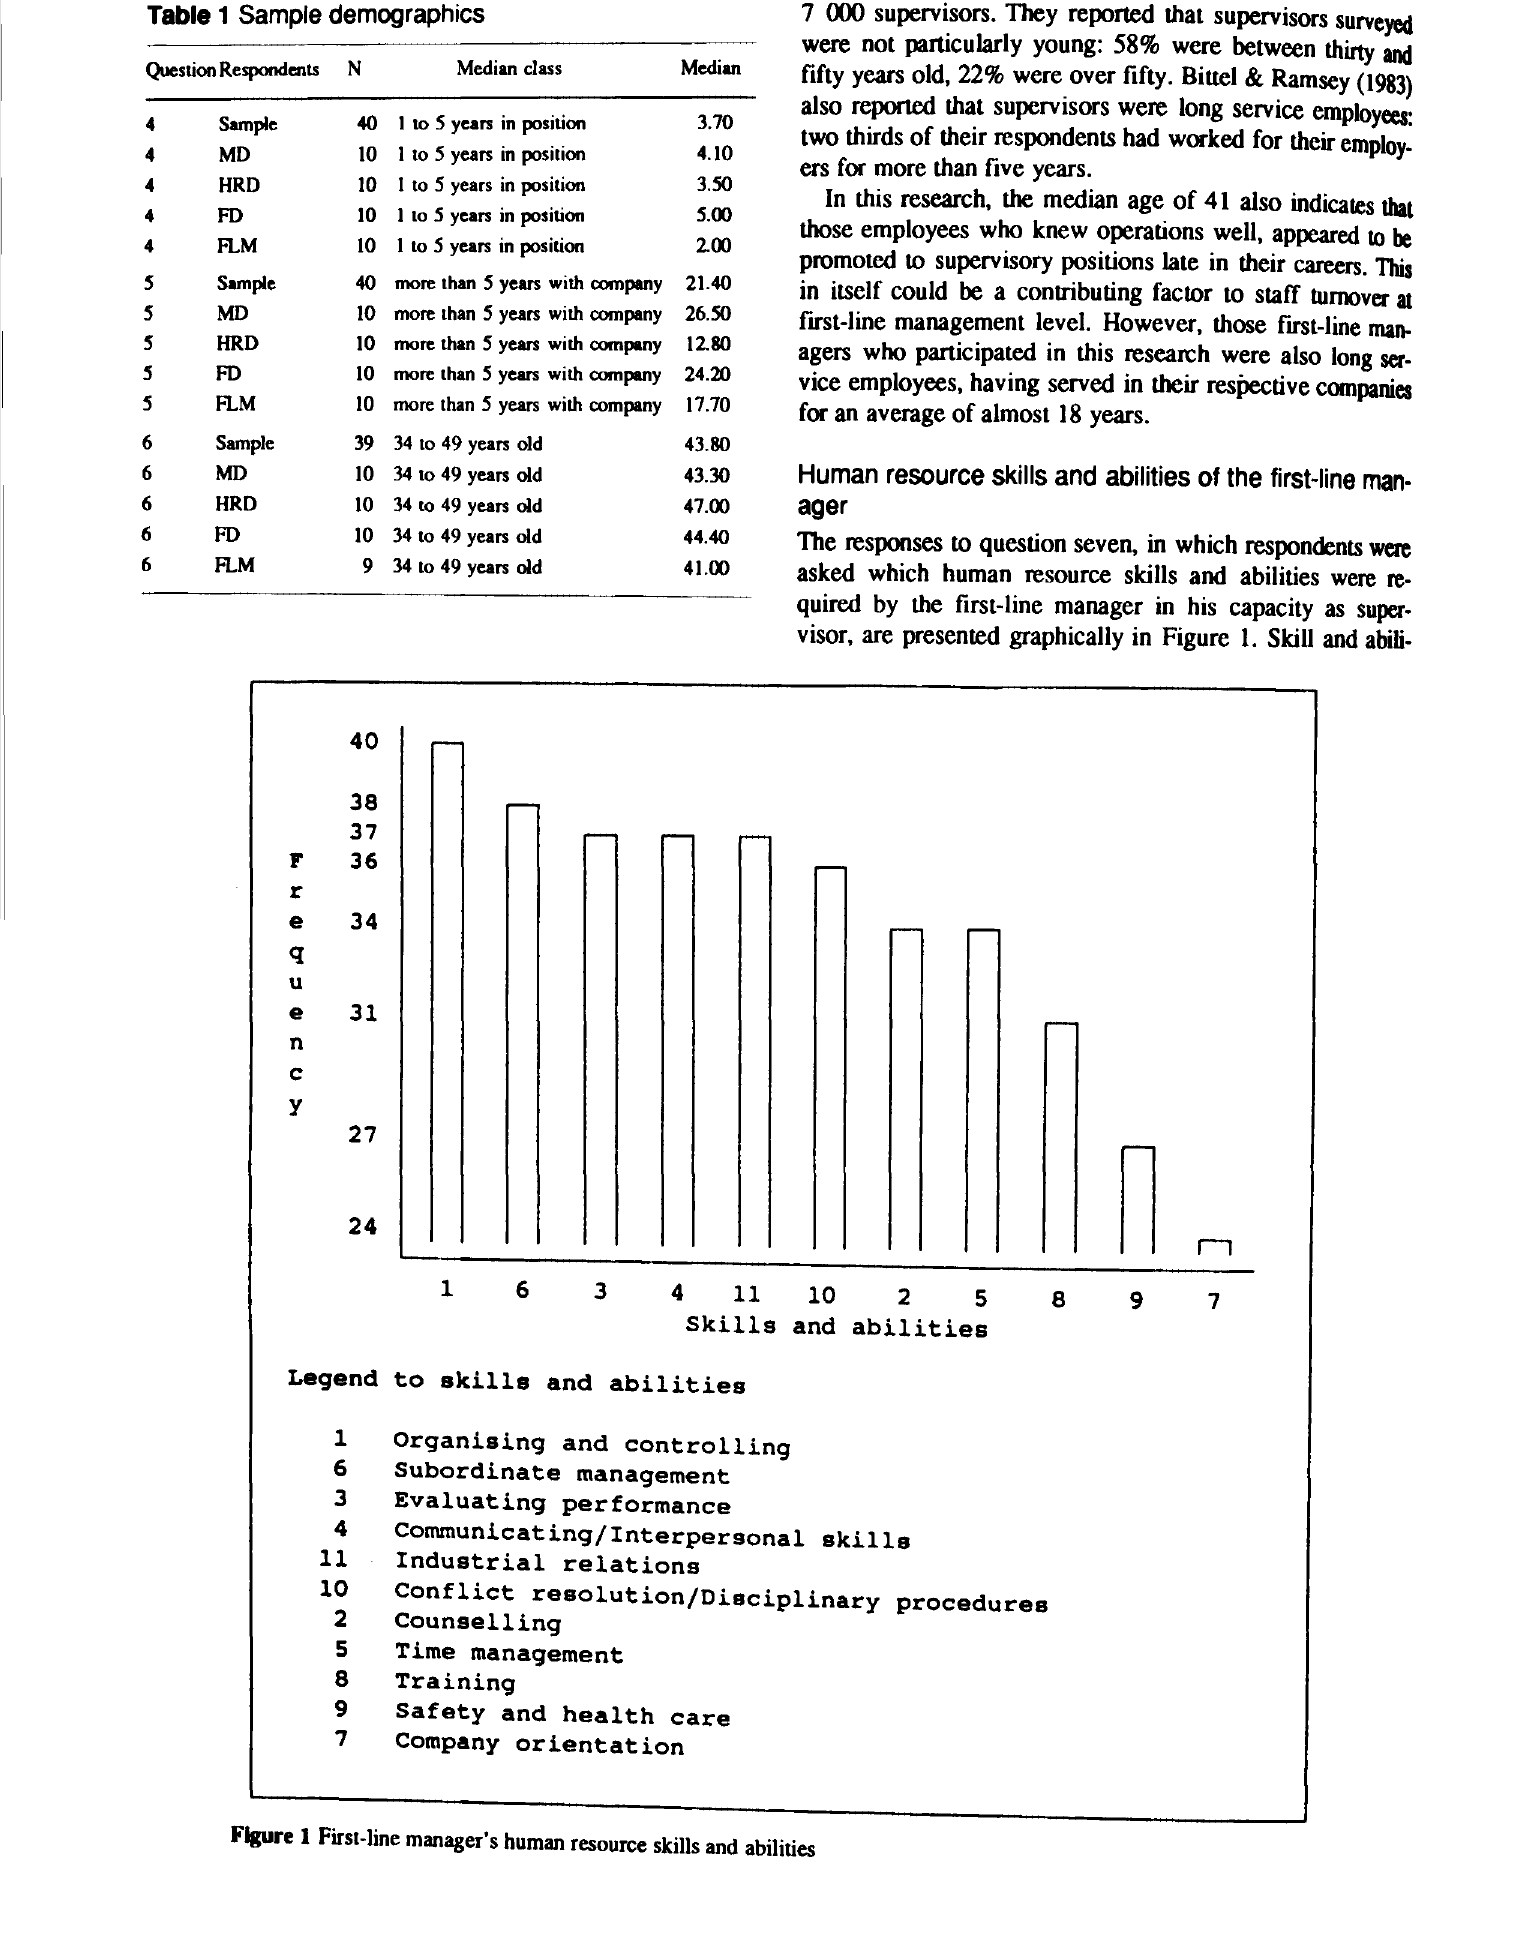
Figure 1 First-line manager's human resource skills and